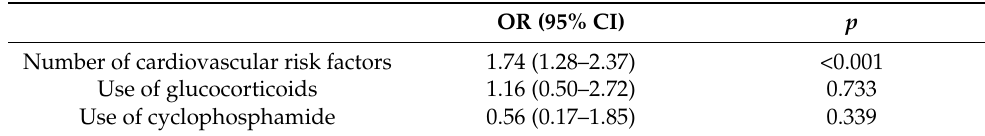
Table 4. Factors associated with the occurrence of major cardiovascular events during the follow- up found in the multivariate analysis of the OSTEOVAS cohort.